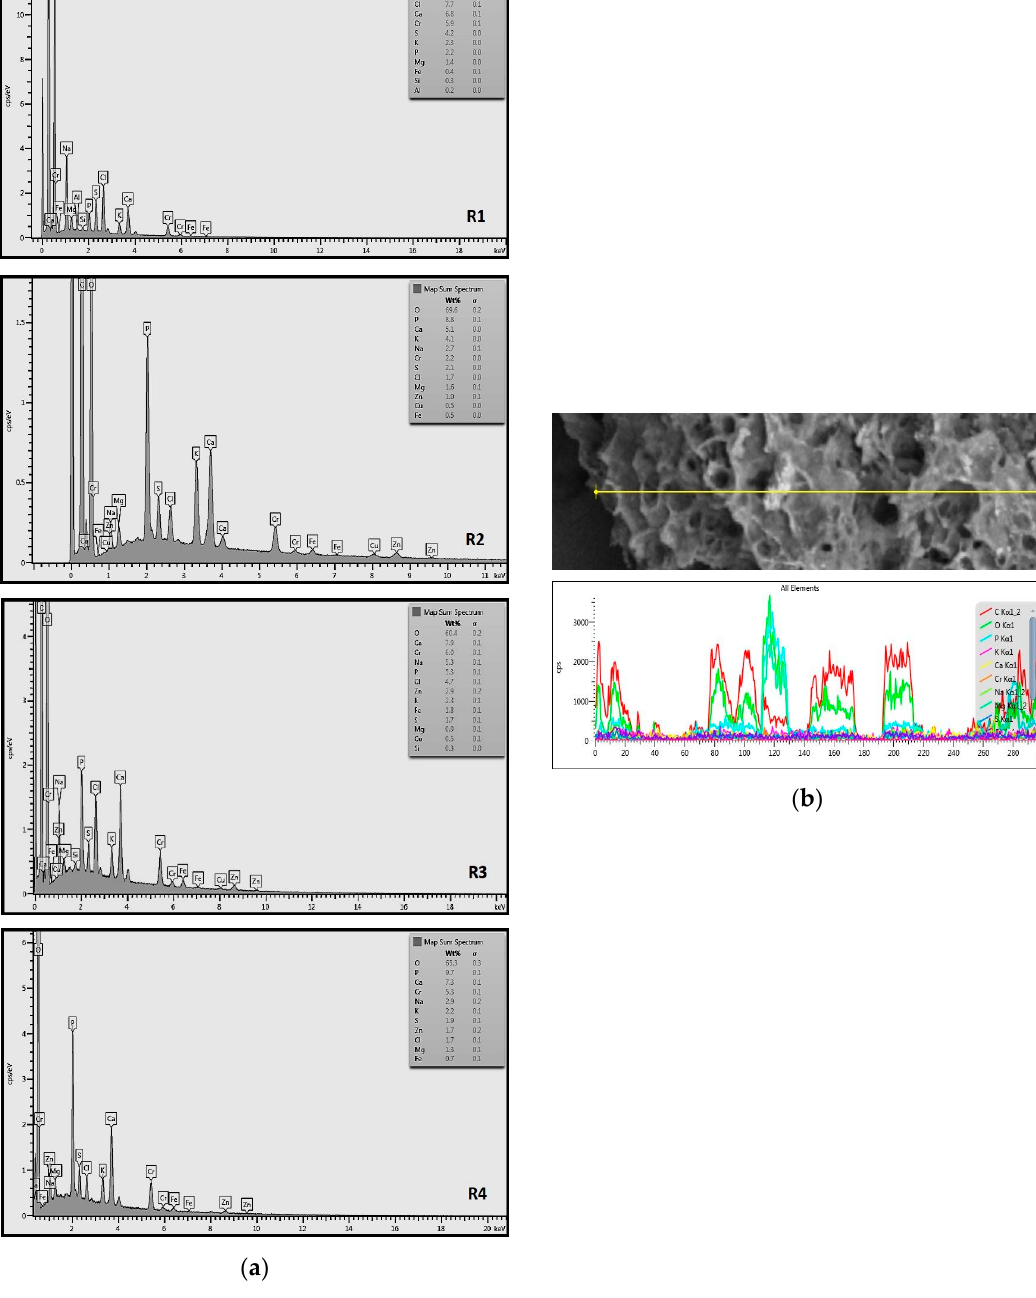
Figure 3. EDS spectra of the elemental composition Aerobic Granular Sludge (AGS) for the measurement area according to Figure 4b ( a ) and the elemental composition (qualitative) of the fragment of the granule from reactor R2 ( b ).